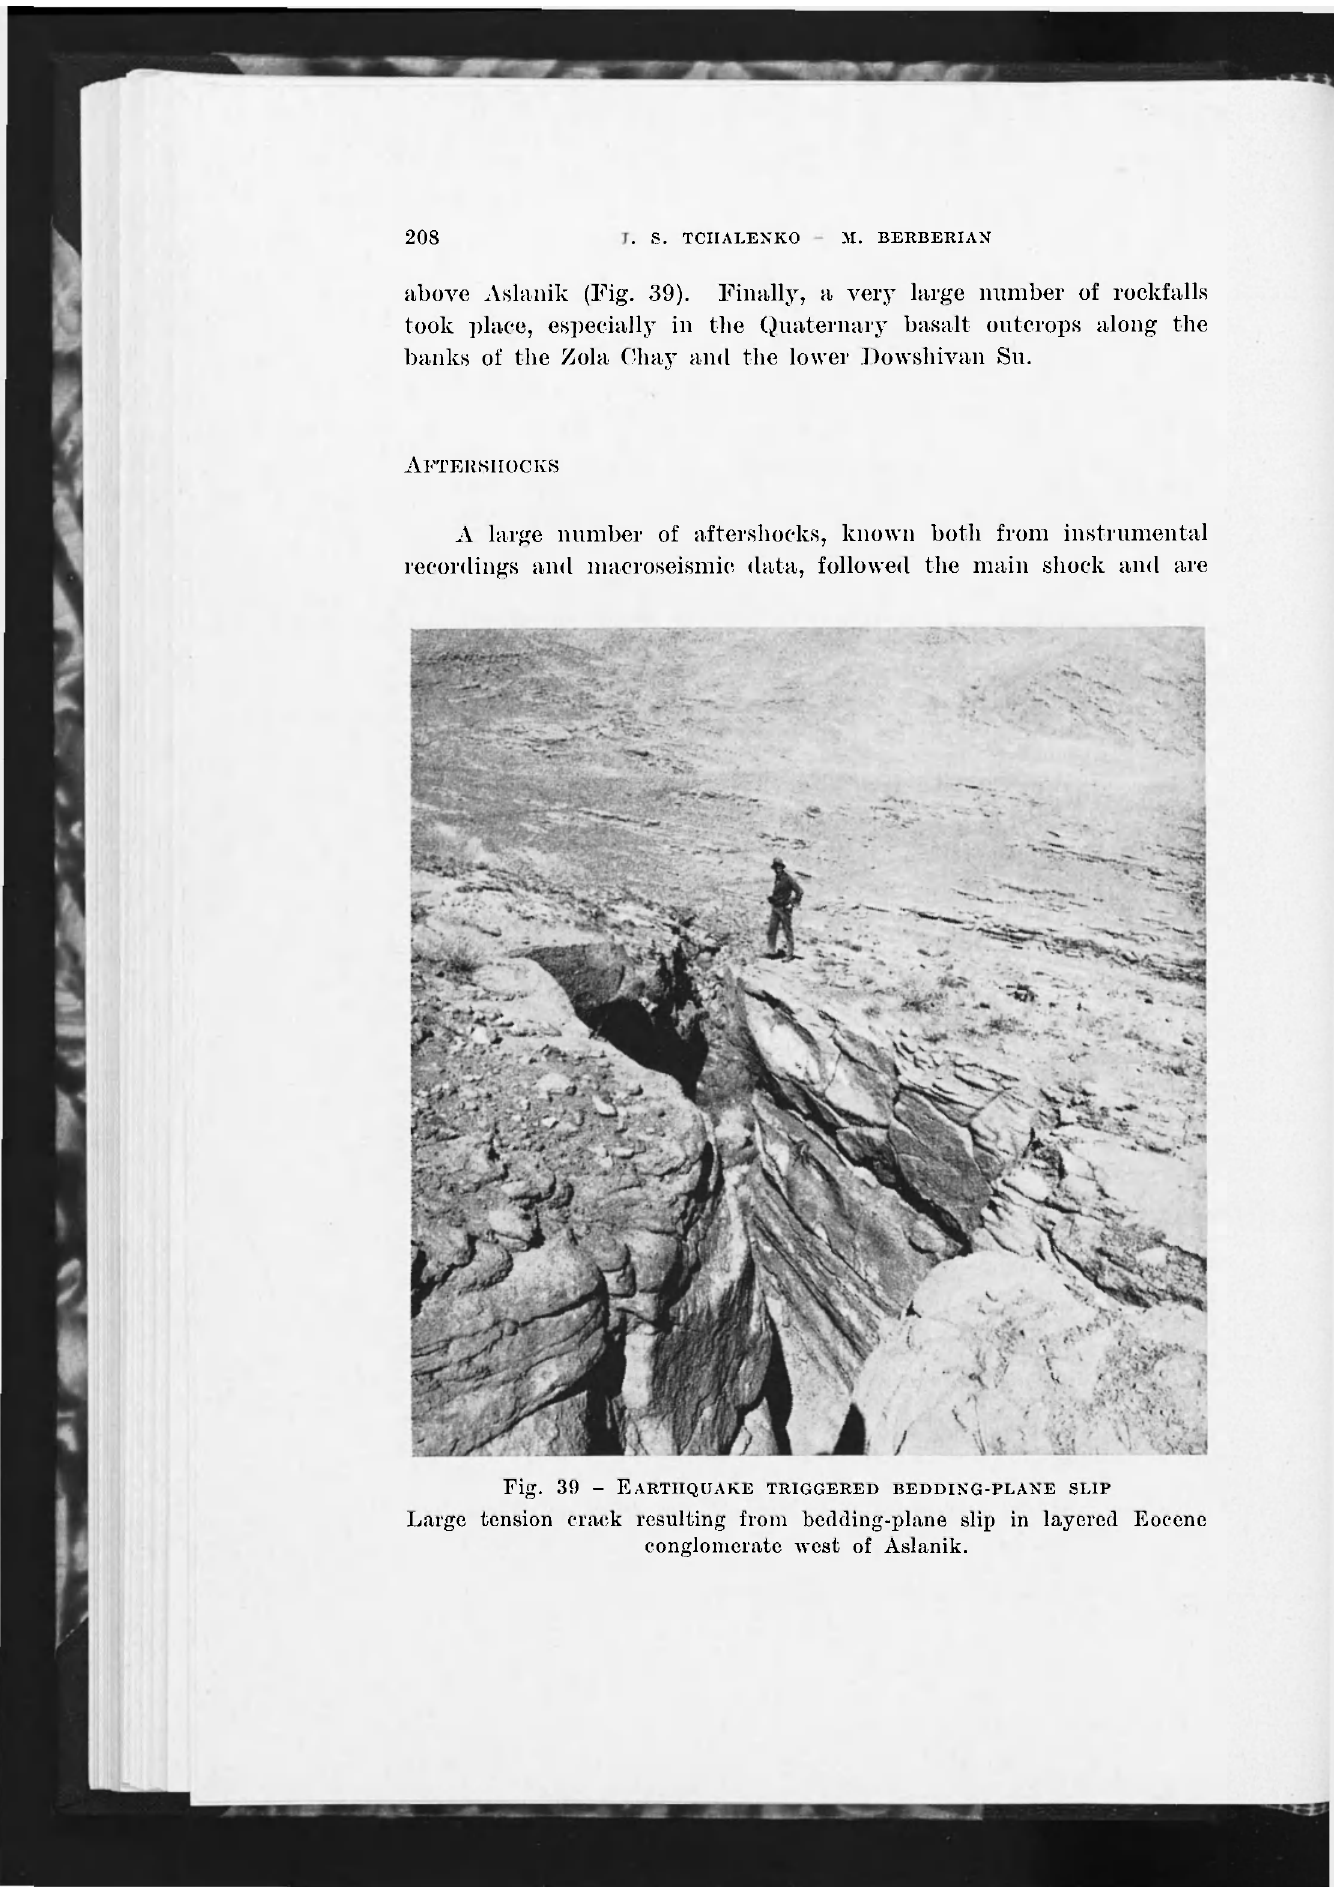
conglomerate west of